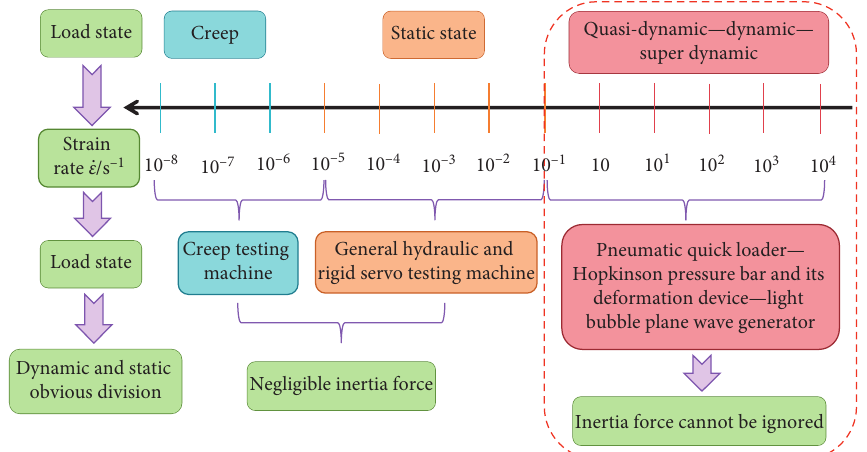
Figure 1: Loading type classified by strain